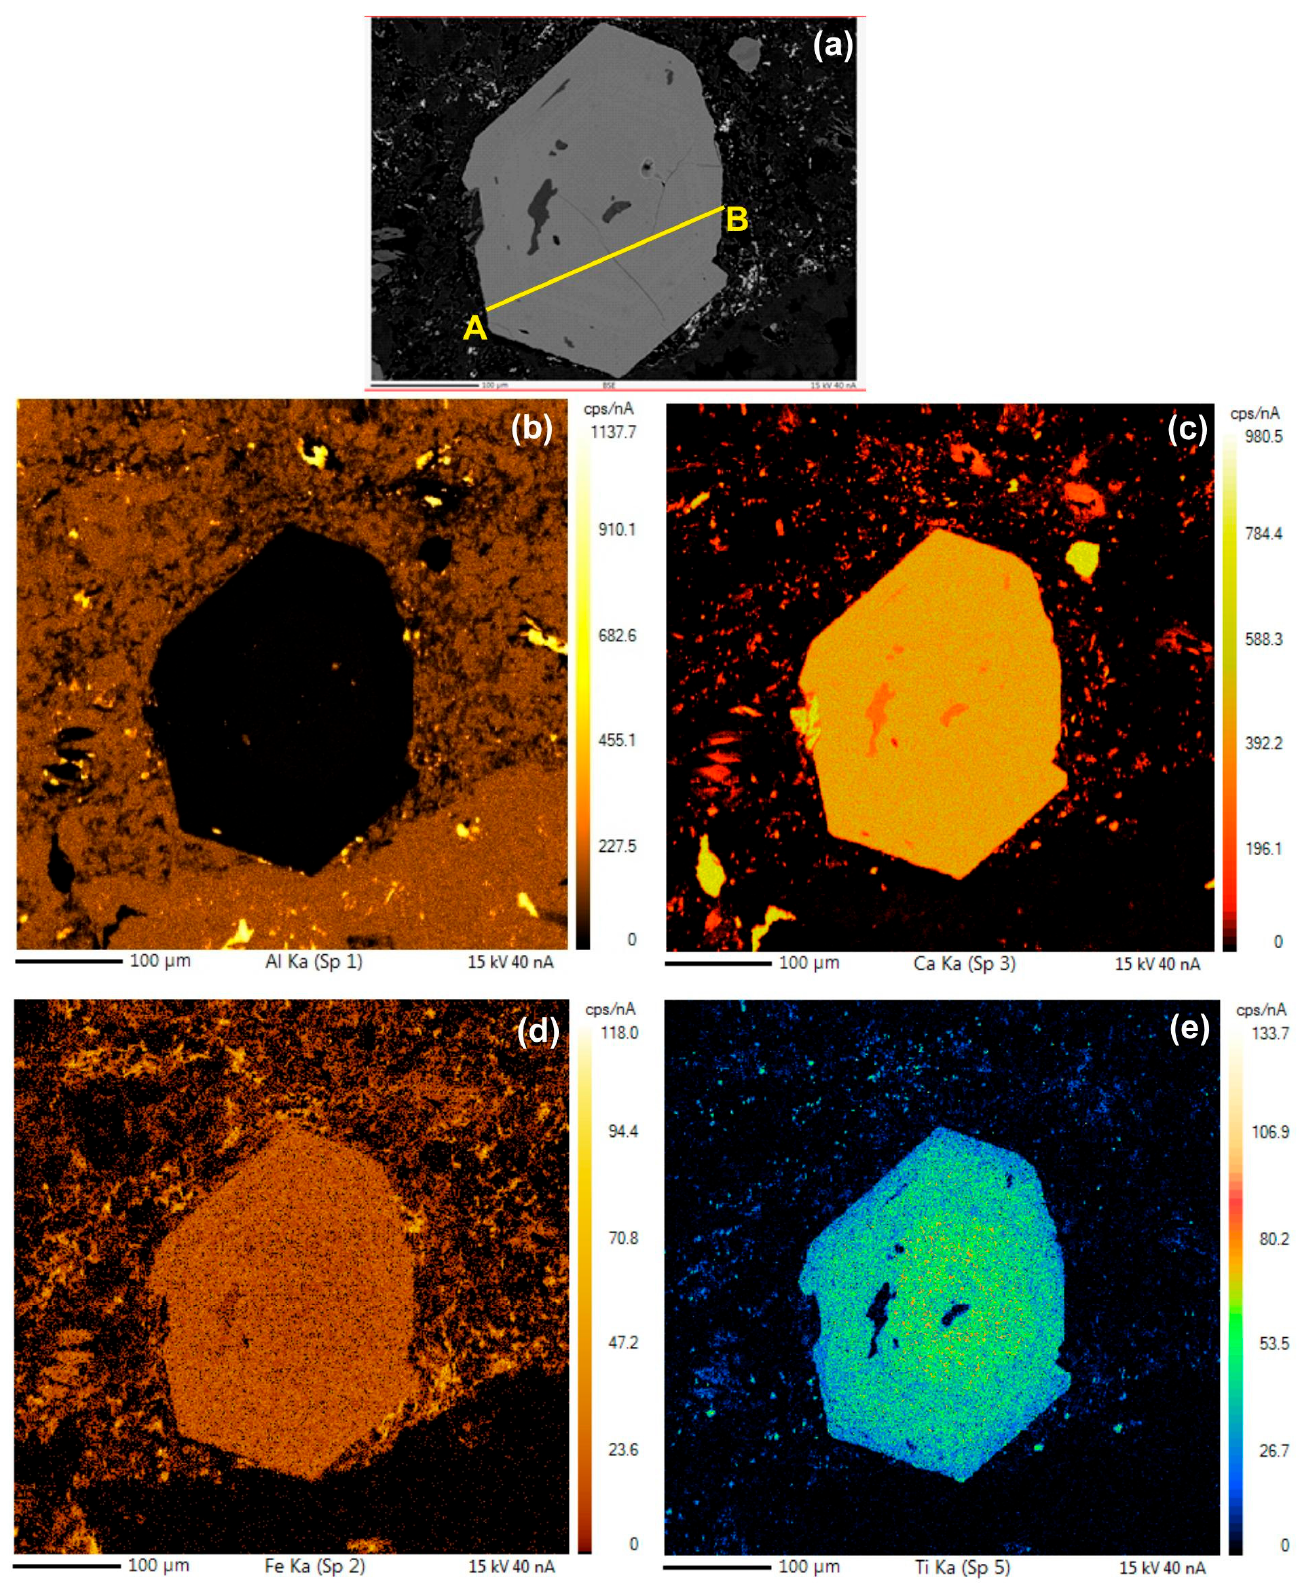
Figure 4. ( a ) BSE images of garnet grain; no substantial zonation is observed. AB line shown in the figure is used for the EPMA line scan for different oxides as displayed in Figure 5. ( b – e ) X-Ray Elemental maps for Al, Ca, Fe, and Ti, respec- tively.